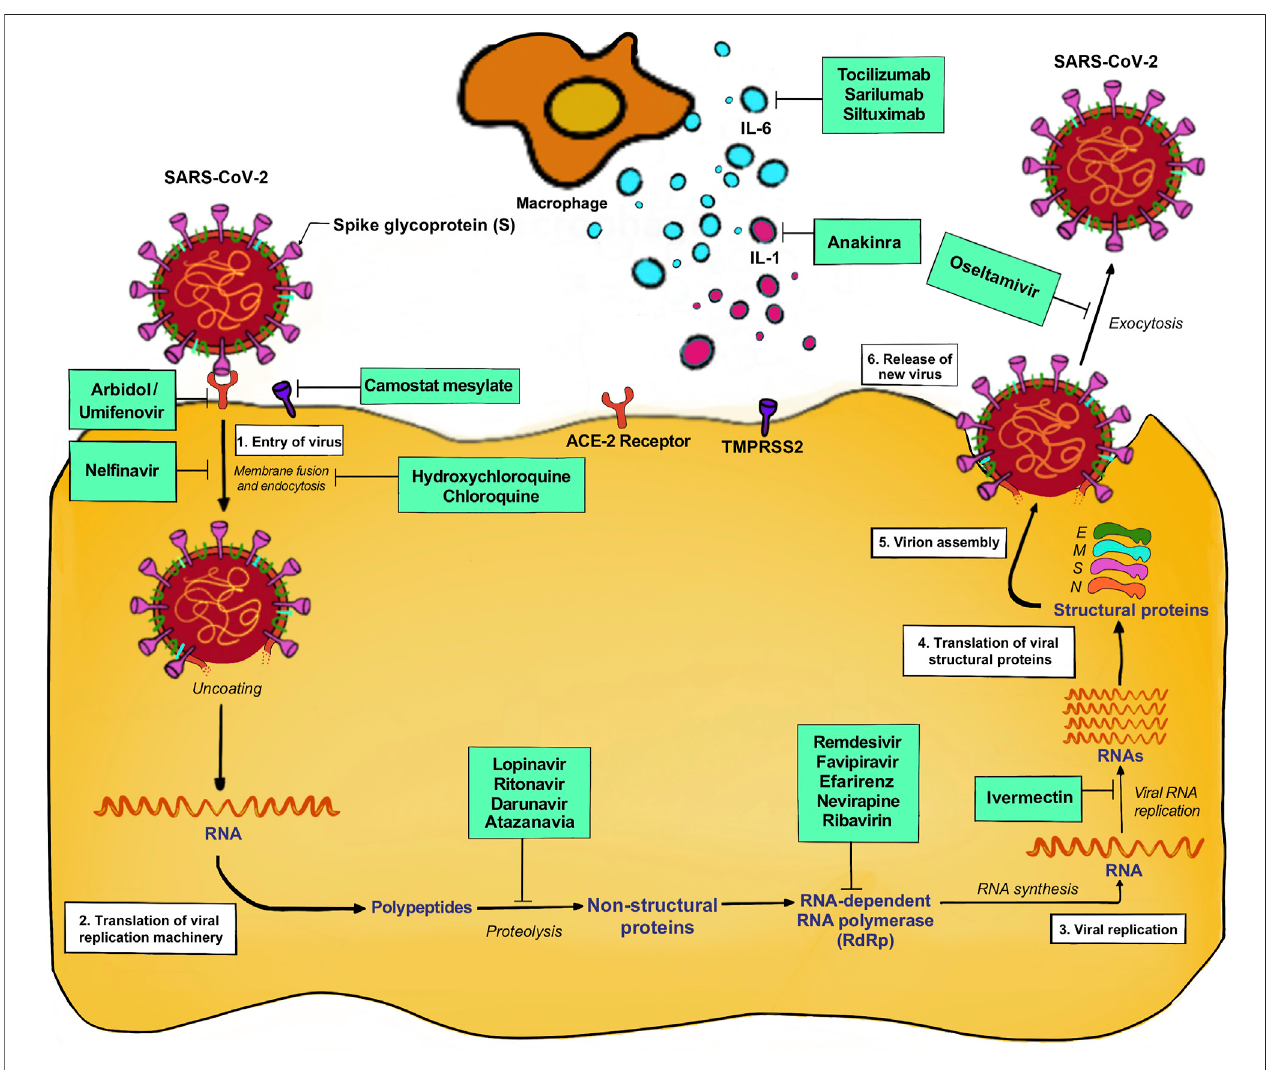
FIGURE 4 | Drugs act in different phases of SARS-CoV-2 life